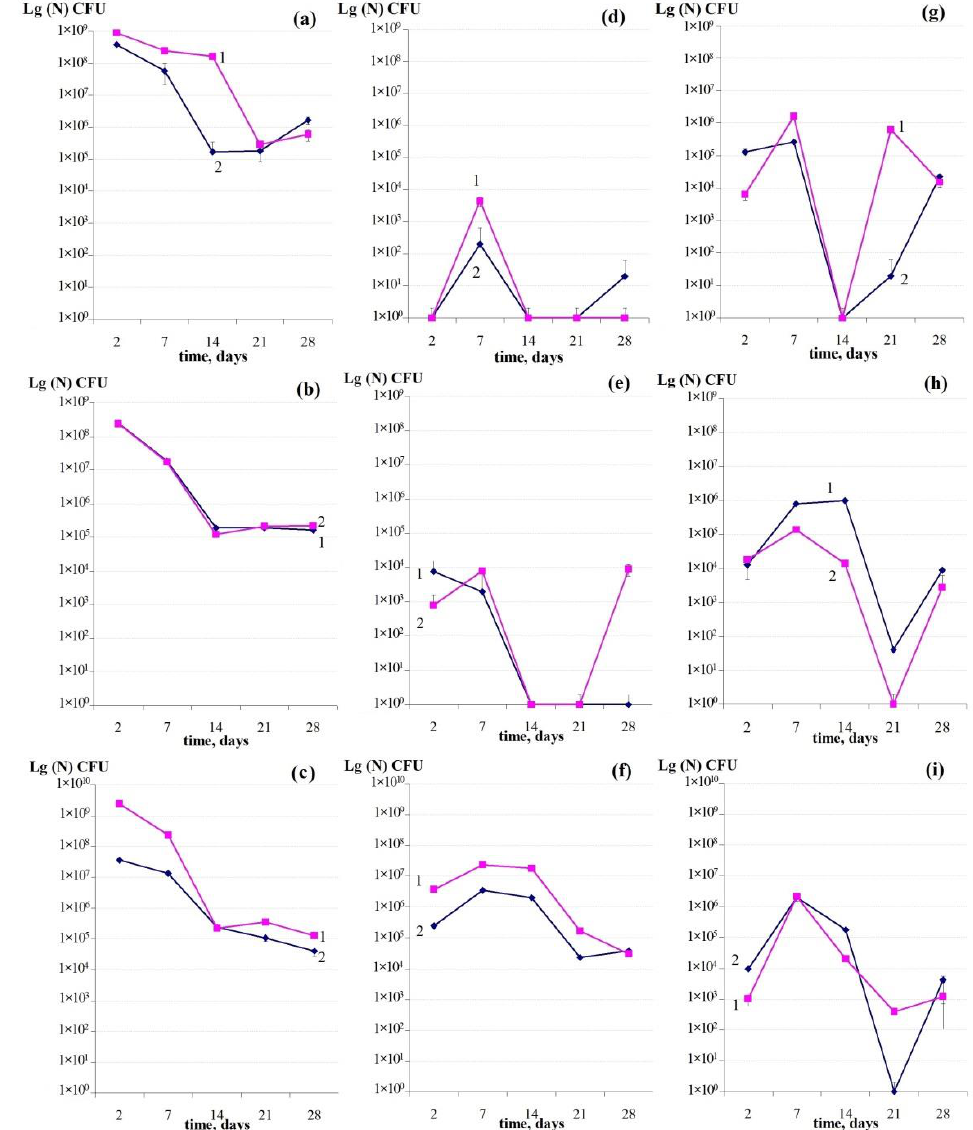
Figure 4. Dynamics of changes in the total number (CFU/filter) of cells ( a – c ), number of persisters ( d – f ) and thermoresistant cells ( g – i ) in the mono-species biofilms: 1, P. aeruginosa and 2, P. extremorientalis ( a , d , g ); 1, E. coli and 2, S. typhimurium ( b , e , h ); 1, S. aureus and 2, K. rhizophila ( c , f , i ) during 28-day incubation.